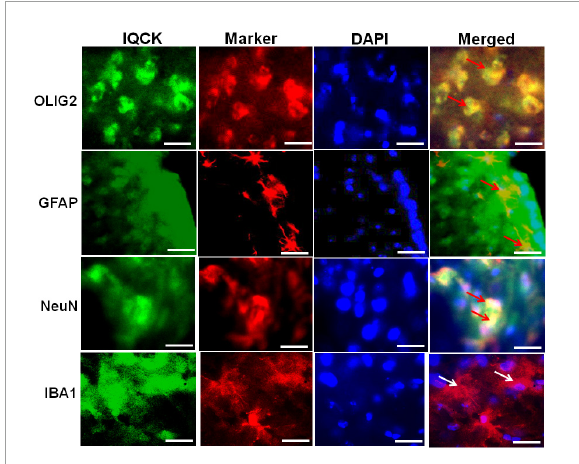
FIGURE5 IQCK is expressed in different cell types in the cortical region of the mouse brain. Representative micrographs of cortical region serial sections that were immunostained with cell-type-specific antibodies such as Iba1 for microglia, NeuN for neurons, Gfap for astrocytes, and Olig2 for oligodendroglia (shown in red fluorescence) together with the polyclonal IQCK antibody (green fluorescence), and sections were counterstained with DAPI for detecting nuclei (blue fluorescence). IQCK expression was present in neurons, oligodendrocytes, and astrocytes but not in microglia. Control slides without the primary antibodies showed no signals (data not shown). The yellow color in the merged images demonstrates IQCK expression in the specific cell types as indicated by red arrows. White arrows for microglia indicate negativity for IQCK expression. Scale bars in all the images represent 50 µ